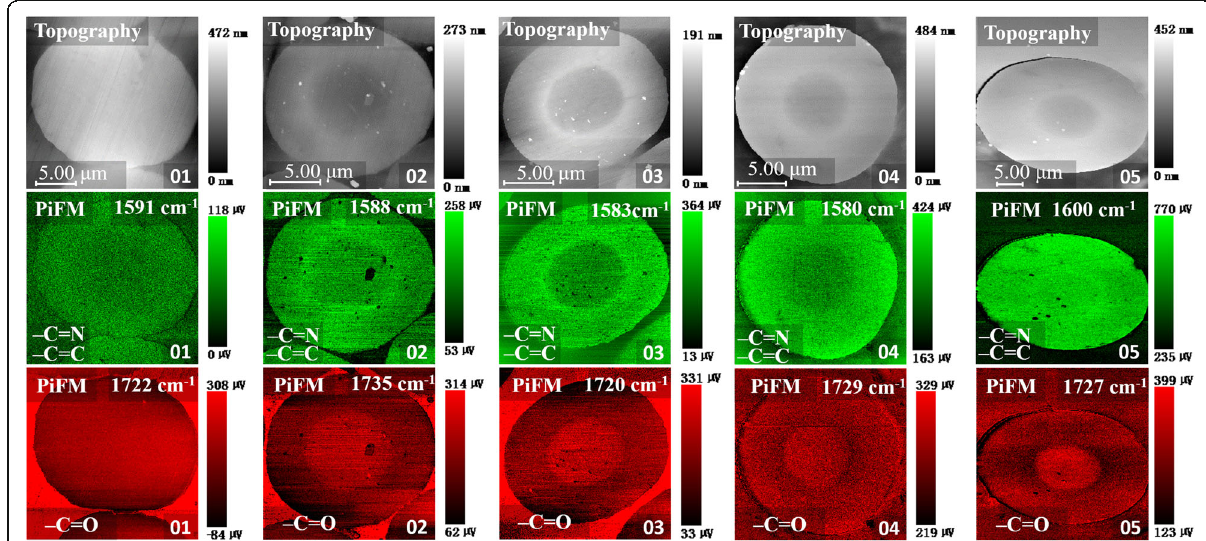
Fig. 3 Topography of samples 01 – 05; PiFM mapping of absorbance intensity at 1600 and 1730 cm − 1 for samples 01 –